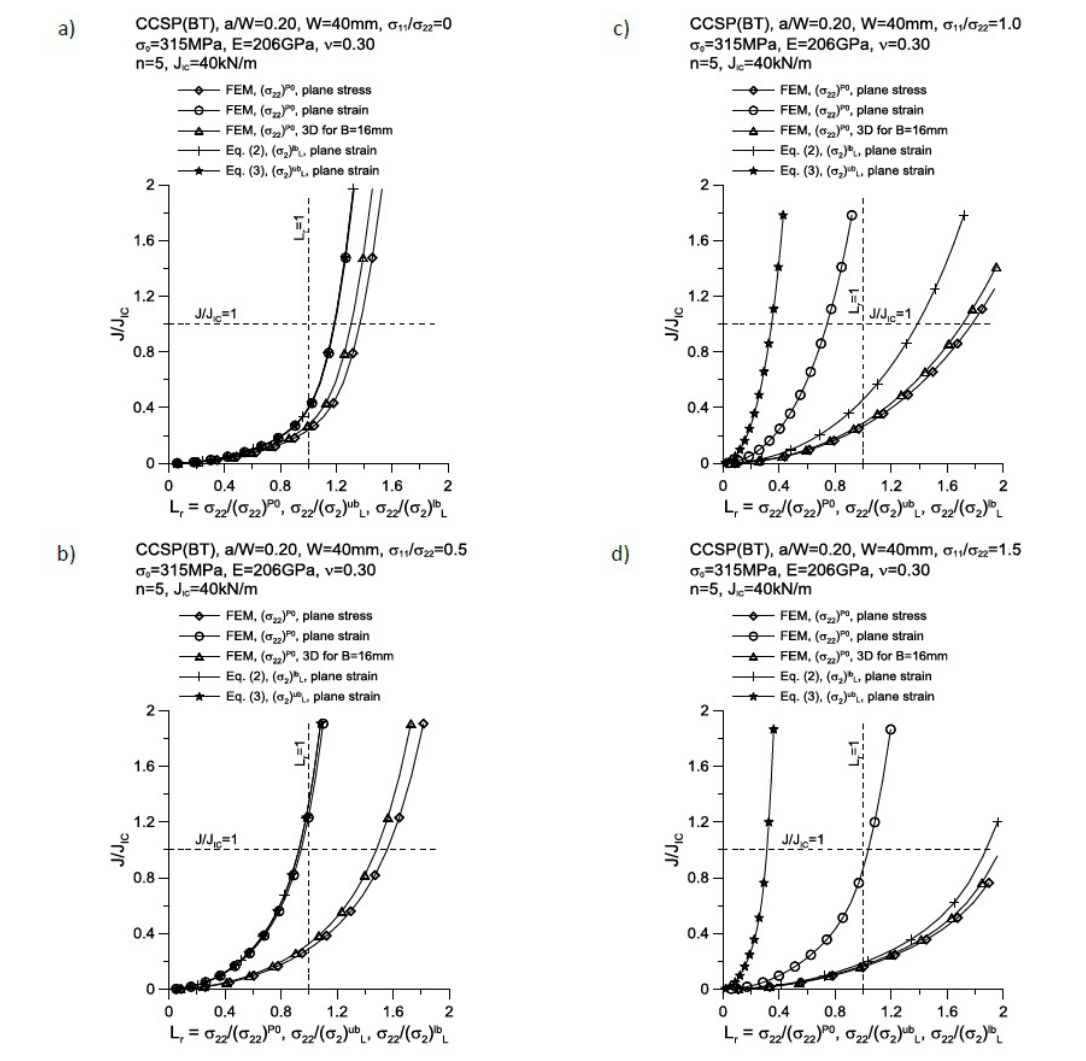
Figure 18: Changes in the numerical values of the J -integral against external load normalized by different values of the limit load for